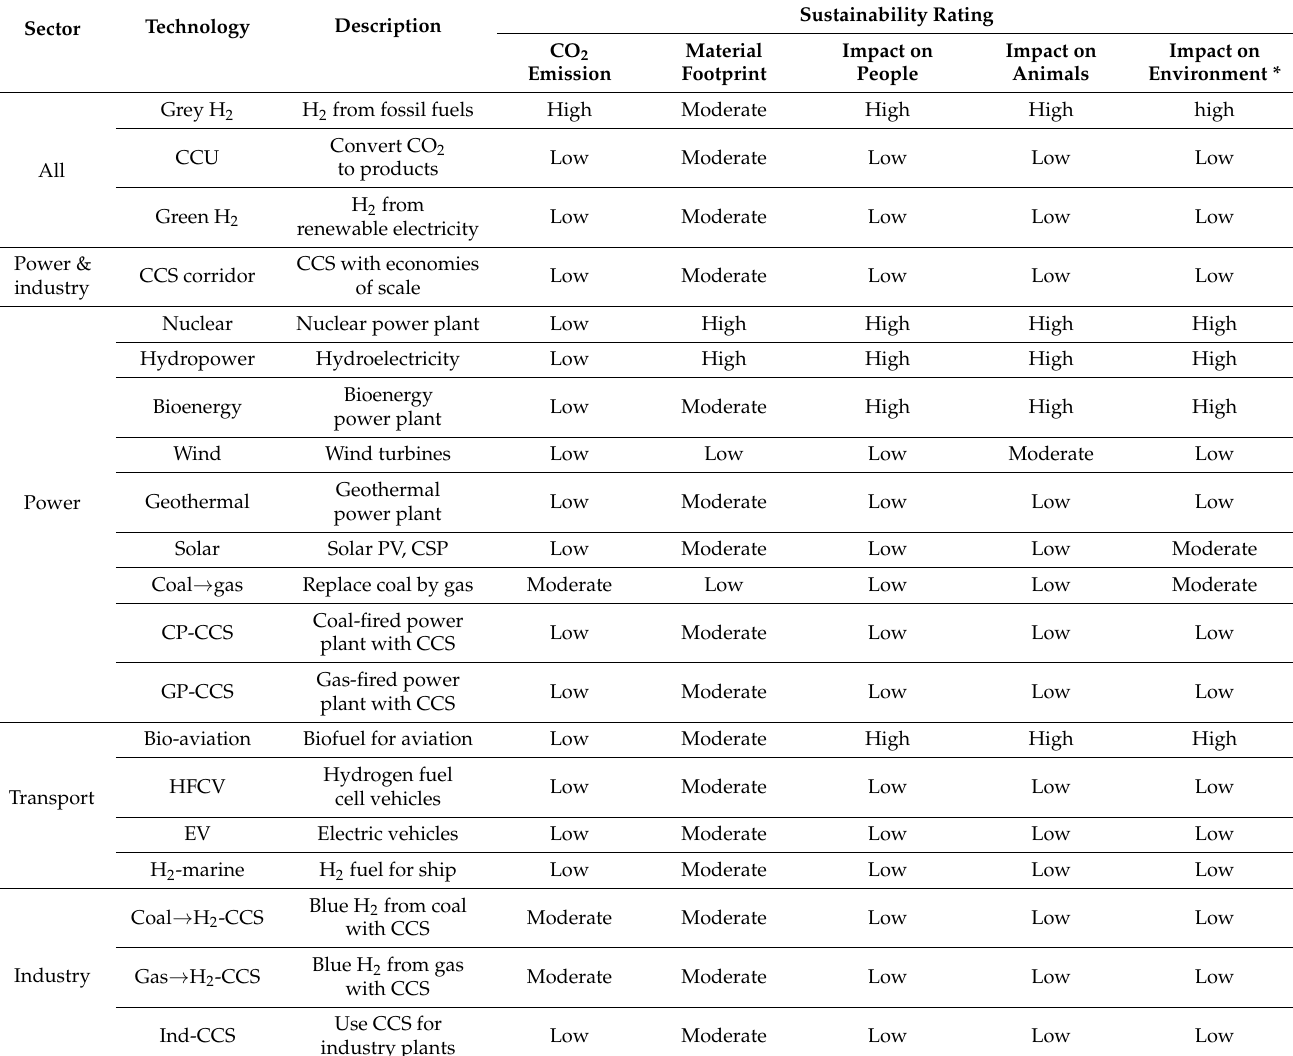
Table 6. Sustainability rating for decarbonization